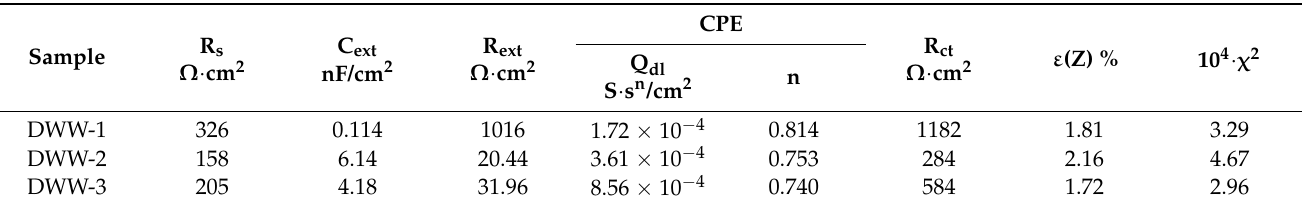
Table 6. Equivalent circuit element values for nodular cast iron samples immersed for 1 h in neutral, acidic, and basic synthetic